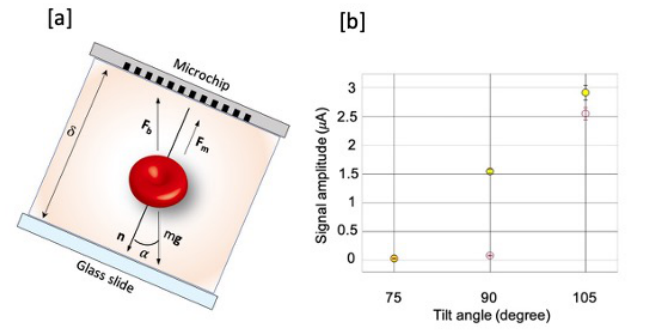
Figure 3. Direction of the forces in the fluidic chamber with respect to the angle configuration in ( a ) and measured current signal at different configuration angles (yellow dots) and the relative signal due to the capture of false positives in ( b ) (red empty